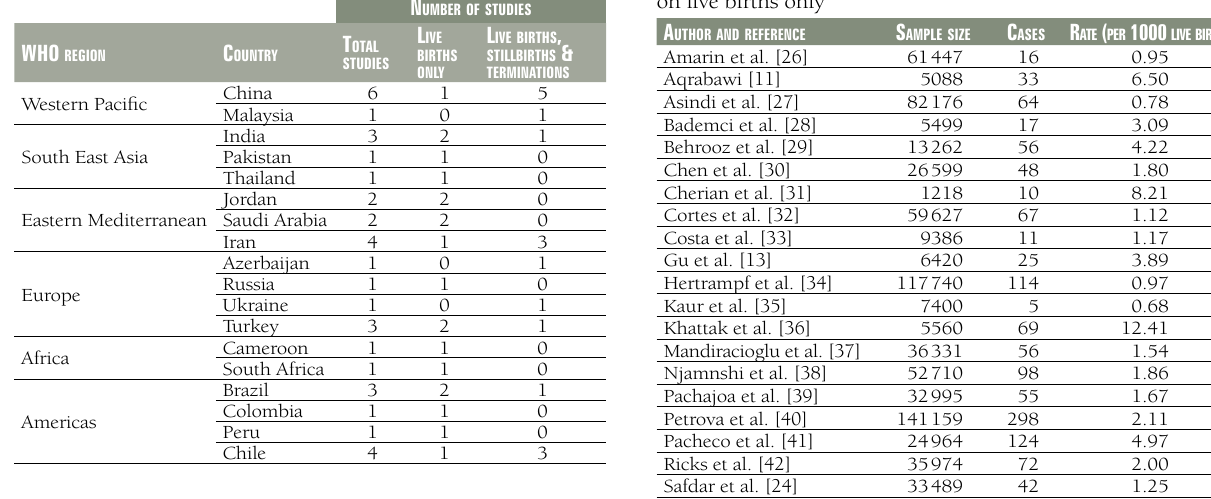
Table 2. Distribution of retained studies by WHO regions